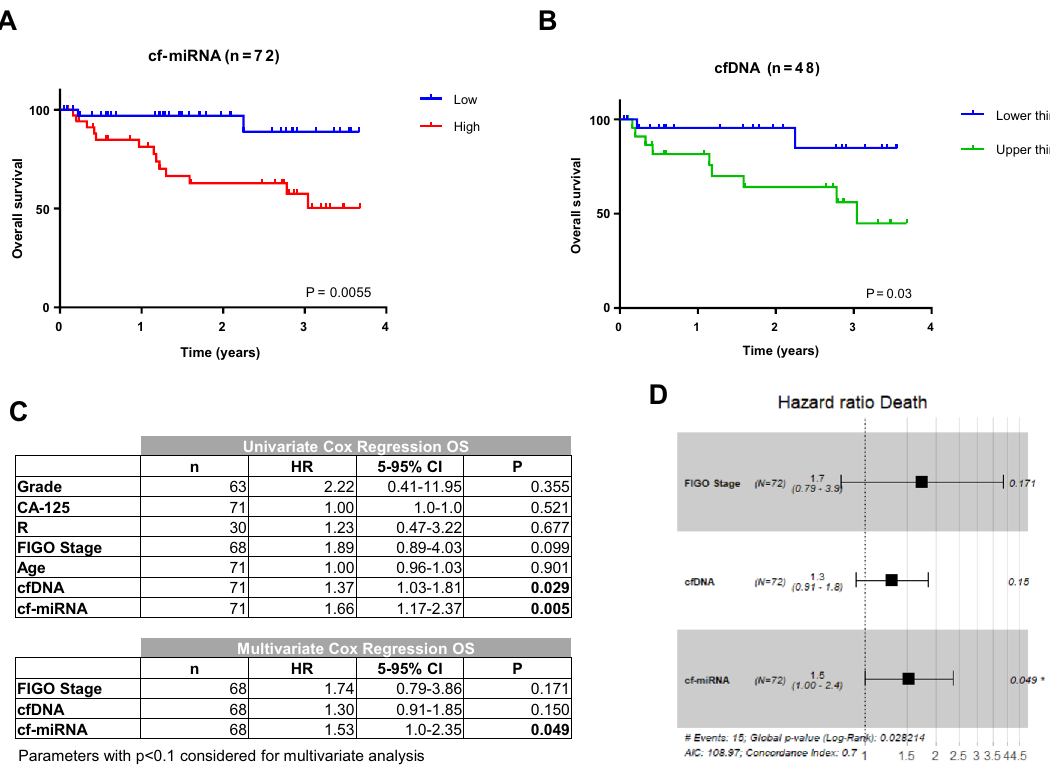
Figure 3. Circulating miRNAs are prognostic biomarkers in OC. Kaplan–Meier curves show a significant correlation between OS and miRNA levels ( A ) and cfDNA levels ( B ) cohorts. Univariate and multivariate cox regression analysis was performed ( C ) and multivariate analysis is displayed as a forest plot ( D